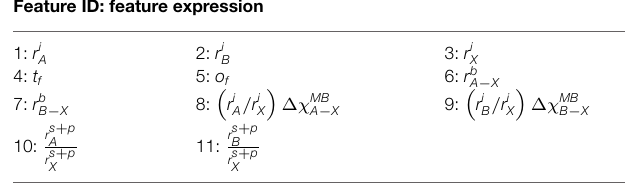
Differences in the Martynov–Batsanov electronegativity scales for A–X and B–X atoms ∆ (cid:31) MB B (cid:0) X r s + p A , r s + p B , and r s + p X Sums of the s and p orbital radii for the A, B, and X